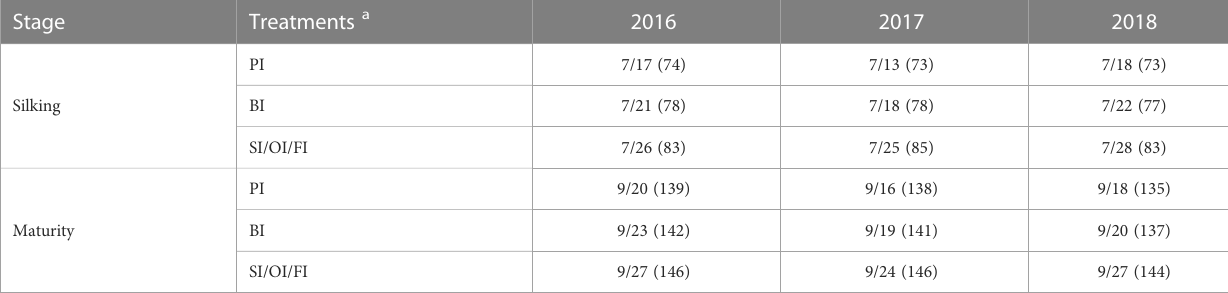
TABLE 1 Developmental progress with different drip irrigation treatments (date, days after sowing).